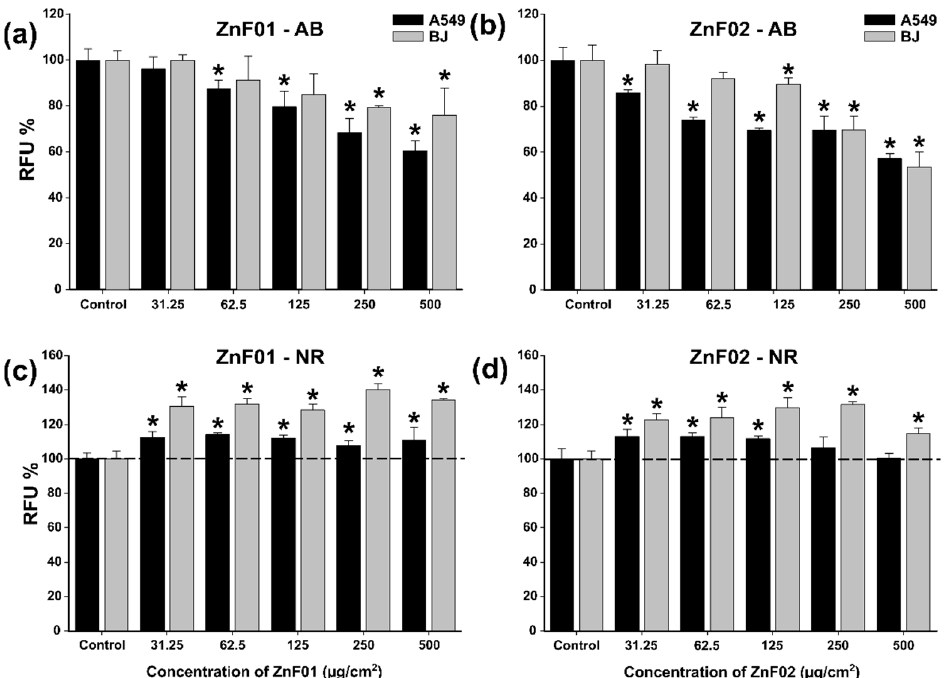
Figure 6. Cytocompatibility of ZnF01 ( b , d ) and ZnF02 ( a , c ) on A549 and BJ cell lines was evaluated after a 24 h exposure. Cellular viability was evaluated using Alamar Blue ( a , b ) and Neutral Red ( c , d ) assays. Data were expressed as relative values to the negative control (100%), as mean ± SD of three biological replicates. Asterisks (*) indicate a significant difference compared to the negative control (ANOVA + Dunn’s; p <